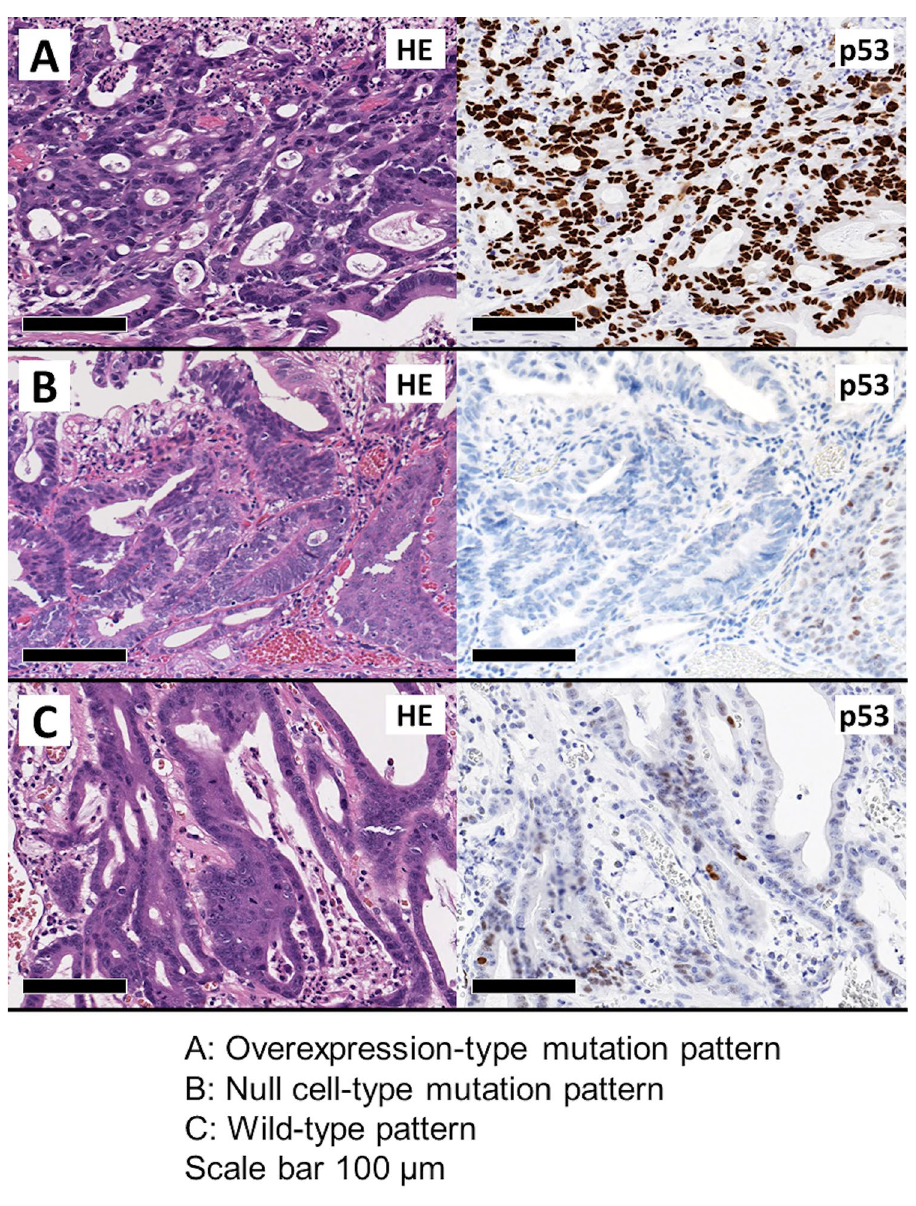
Figure 4. Experimental results for p53 staining. ( A ) Overexpression-type mutation pattern. ( B ) Null cell-type mutation pattern. ( C ) Wild-type pattern. Scale bar, 100 µm. HE hematoxylin and